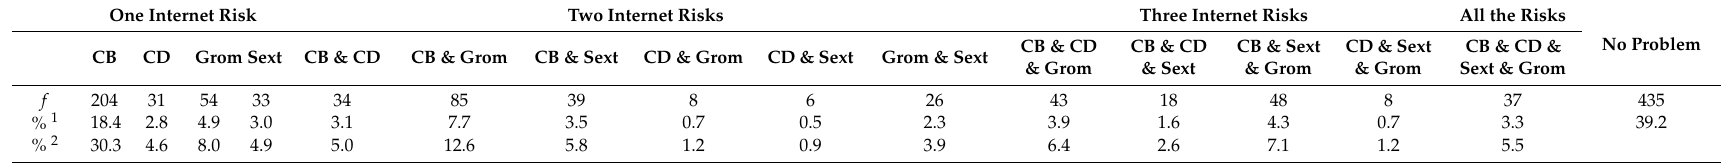
Table 4. Comorbidity between the different Internet risks of participants susceptible to presenting all the risks.